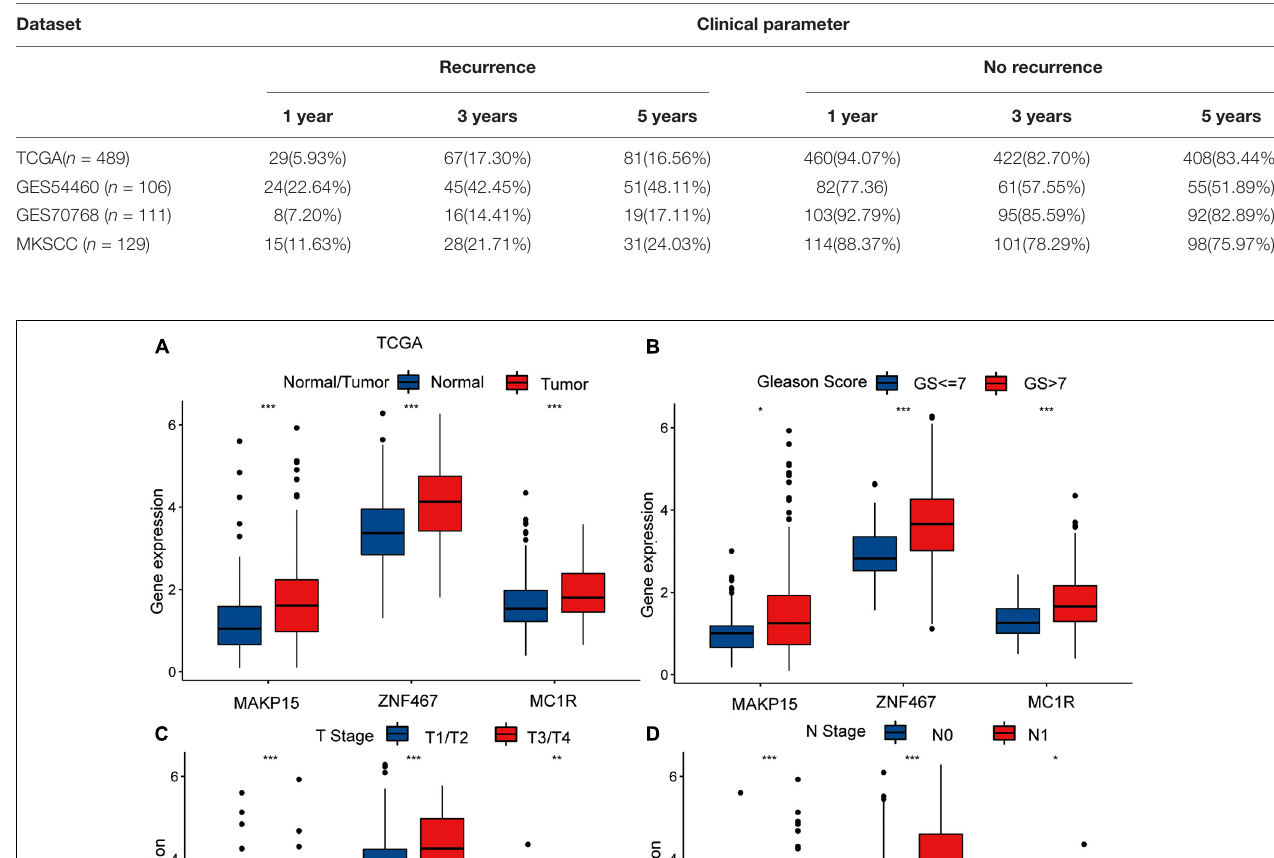
Frontiers in Genetics |